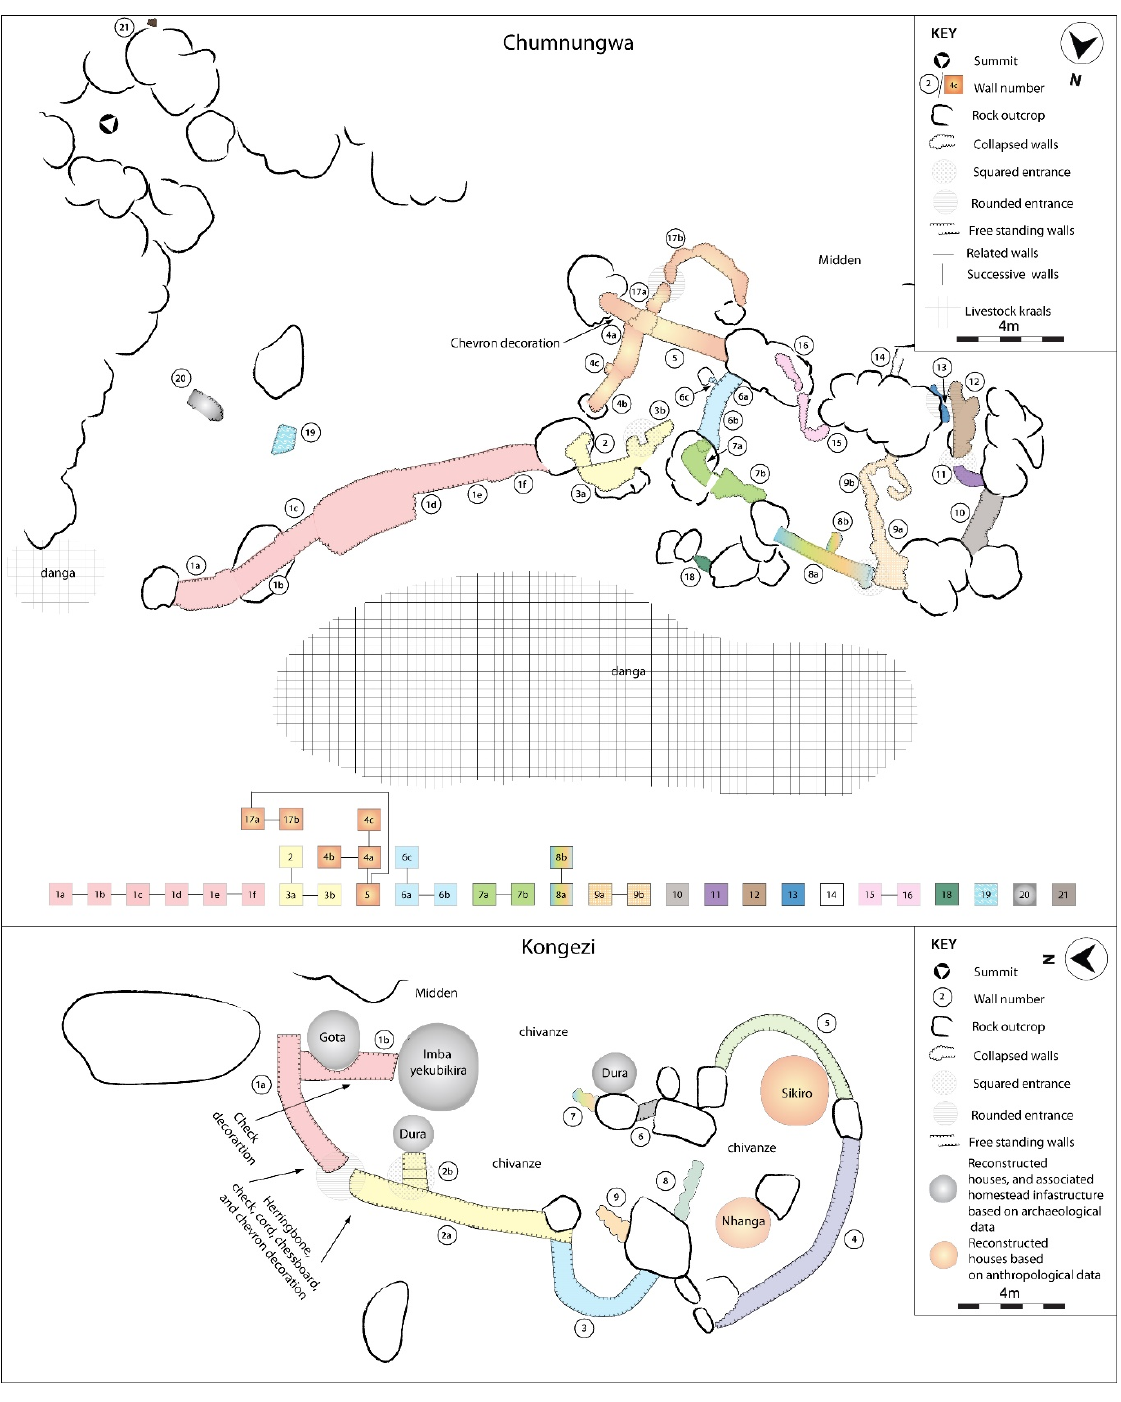
Figure 9. Above is the site map of Chumnungwa showing the construction affinity of the dry-stone walling modelled using Harris Matrix 2 and various features recorded onsite. Below is the site layout of Kongezi showing reconstructed houses and associated settlement infrastructure based on the archaeology, history, and anthropological datasets.